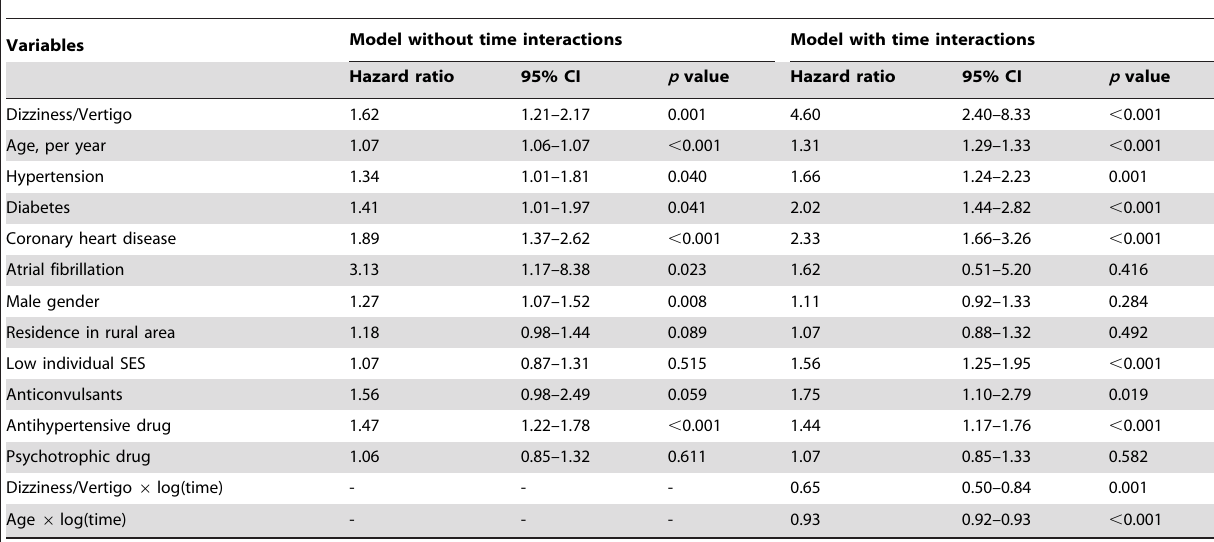
Table 3. Hazard ratios of all vascular events among 25,757